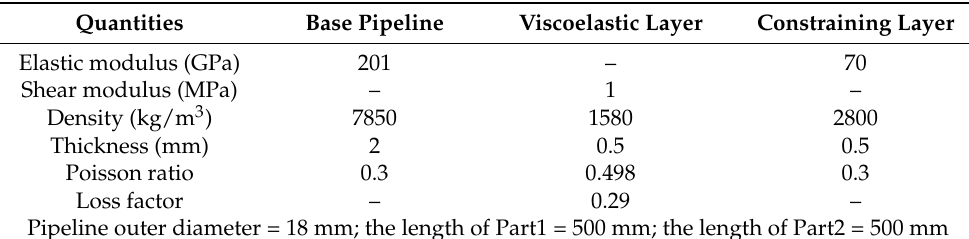
Table 1. Geometrical and material of ACLD pipeline.